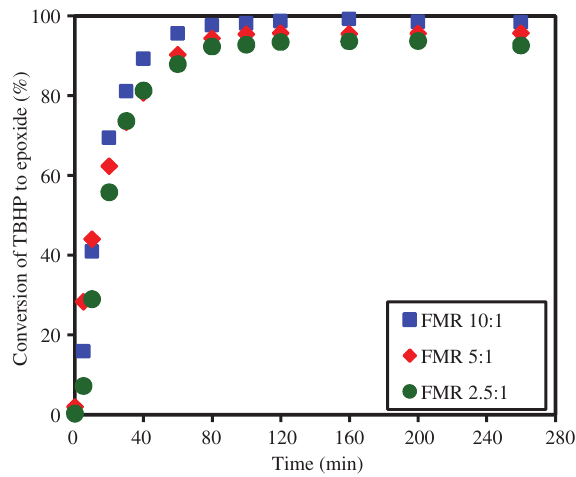
Figure 3 Effect of catalyst loading on the conversion of tert -butyl hydroperoxide (TBHP) to 4-vinyl-1-cyclohexane 1,2-epoxide (4-VCH 1,2-epoxide) for epoxidation of 4-VCH with TBHP catalyzed by poly- styrene 2-(aminomethyl)pyridine supported Mo(VI) complex (Ps.AMP.Mo) catalyst using a batch reactor at a reaction tempera- ture: 70 ° C; feed molar ratio (FMR) of 4-VCH to TBHP: 5:1; stirrer speed: 400